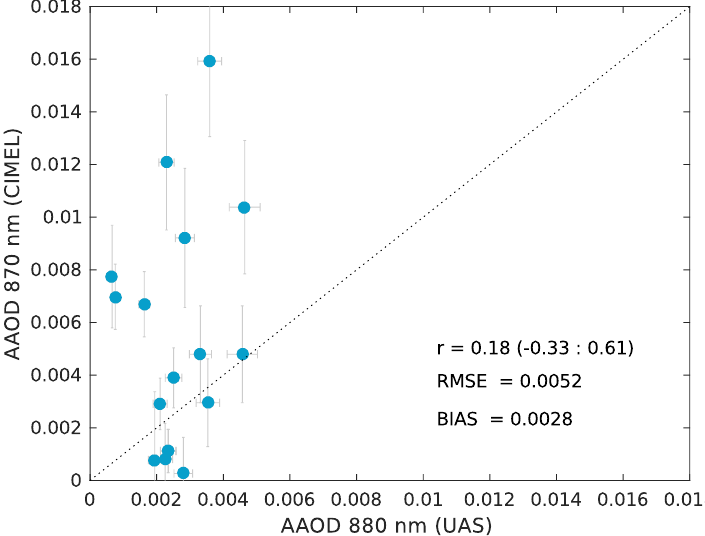
Figure 11. Comparison of the AAOD@870 nm obtained from level 1.5 AERONET data against AAOD@880 nm measured by UAS profiling during June–August 2015 at SolatAOT site [18 cases]. Grey error bars show uncertainties. Dashed line (x = y) only for a